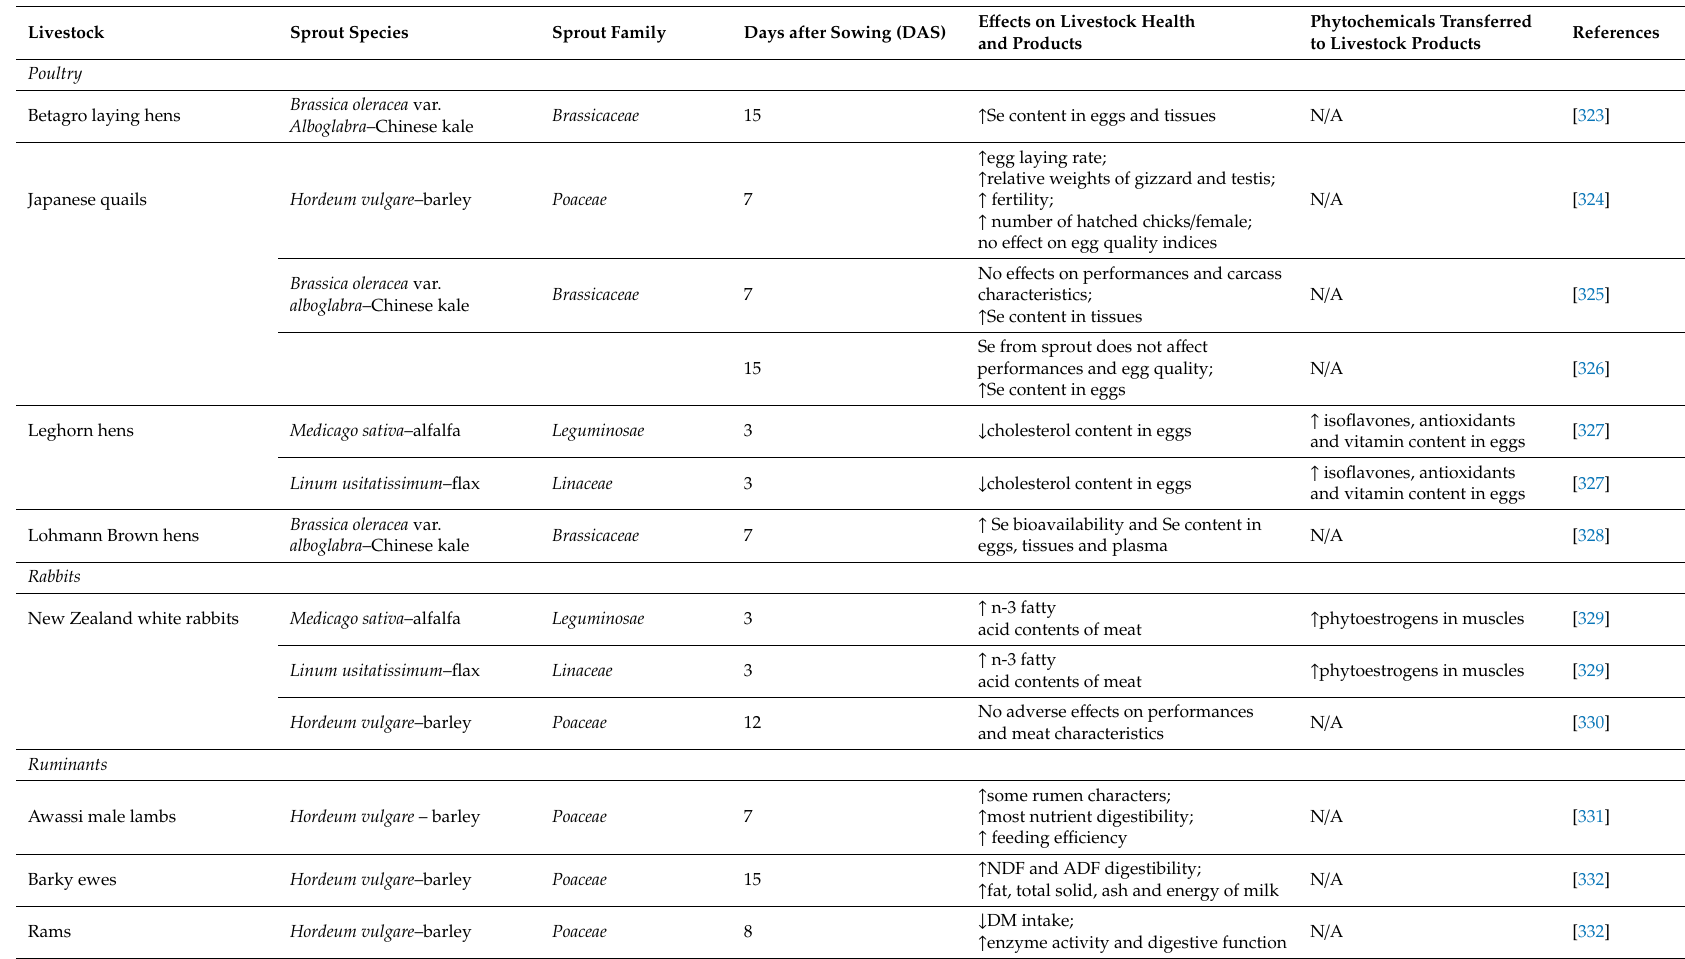
Table 6. Livestock species fed with micro-scale vegetables to improve quality and nutritional features of derived